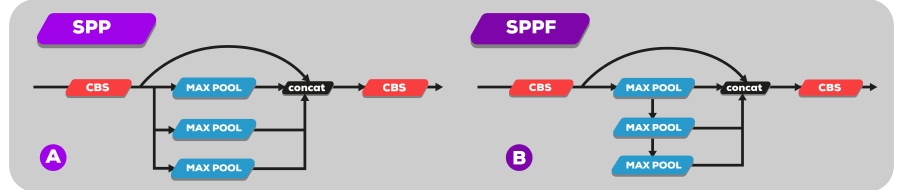
Figure 8. ( A ) SPP module for YOLO series. ( B ) SPPF module.